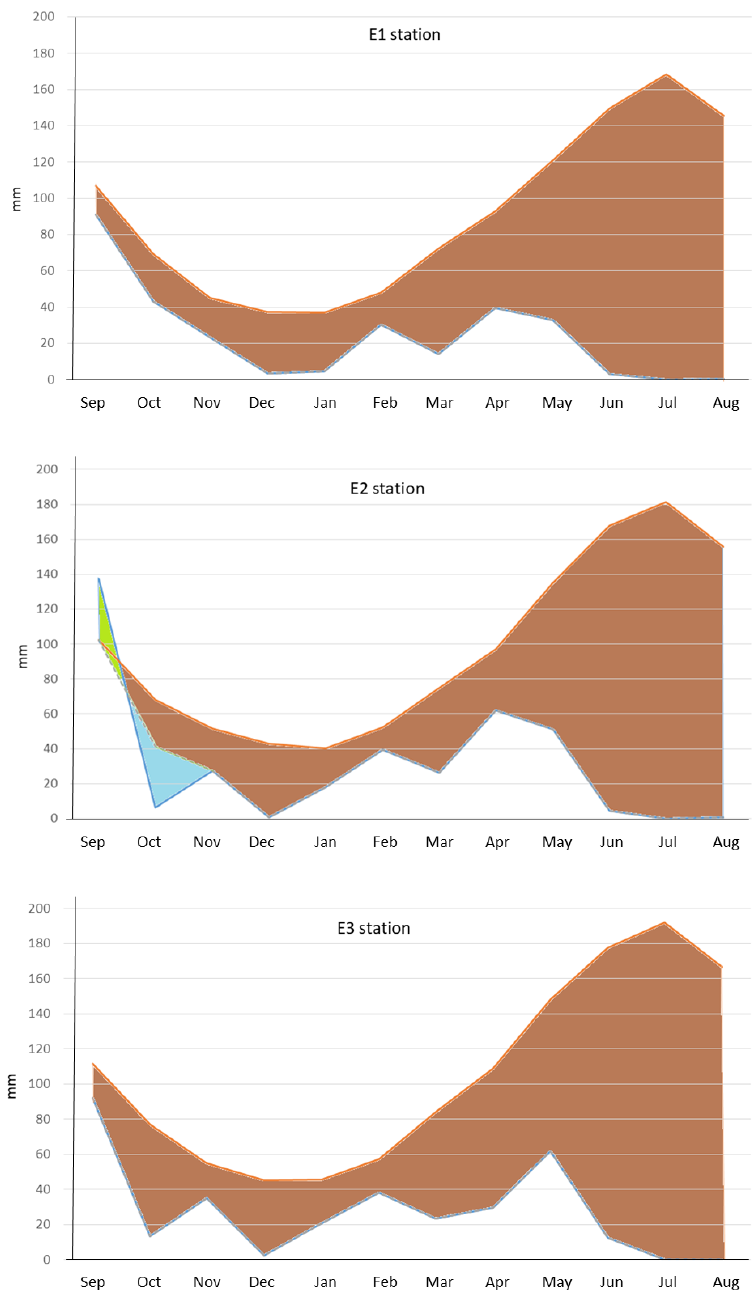
Figure 11. As in Fig. 8 but for the three additional locations in Mallorca (E1, E2 and E3 in Fig. 1).